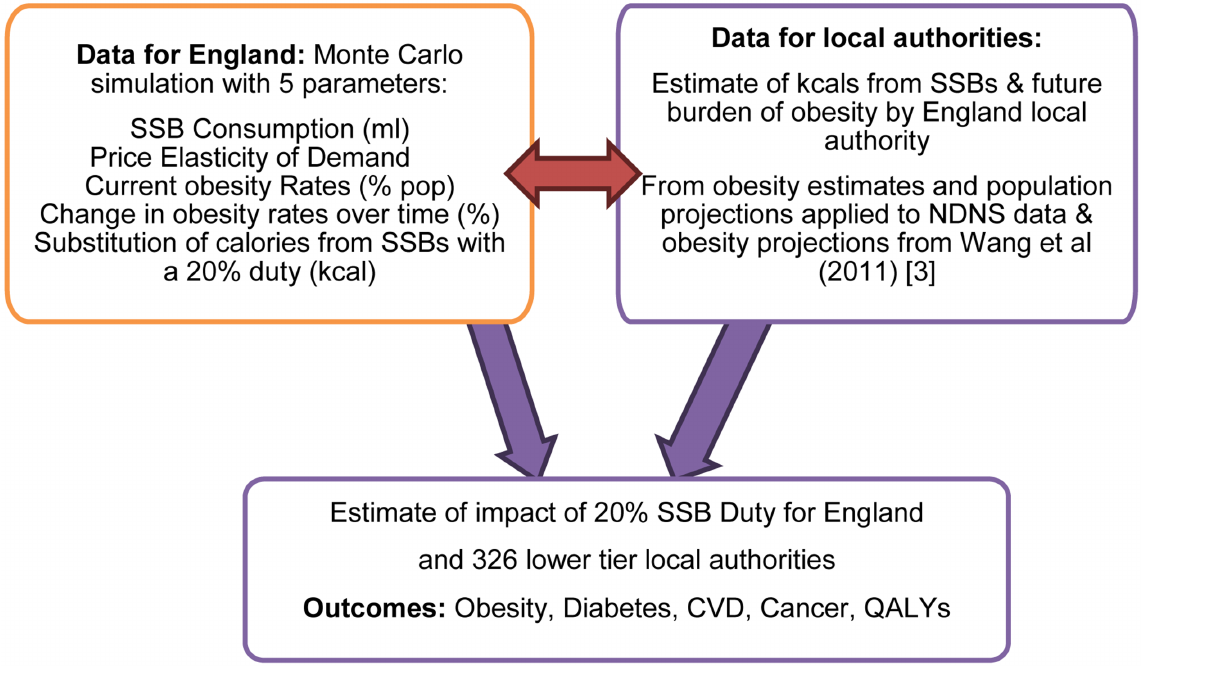
Fig 1. Schematic of SSB model for local authorities in England.